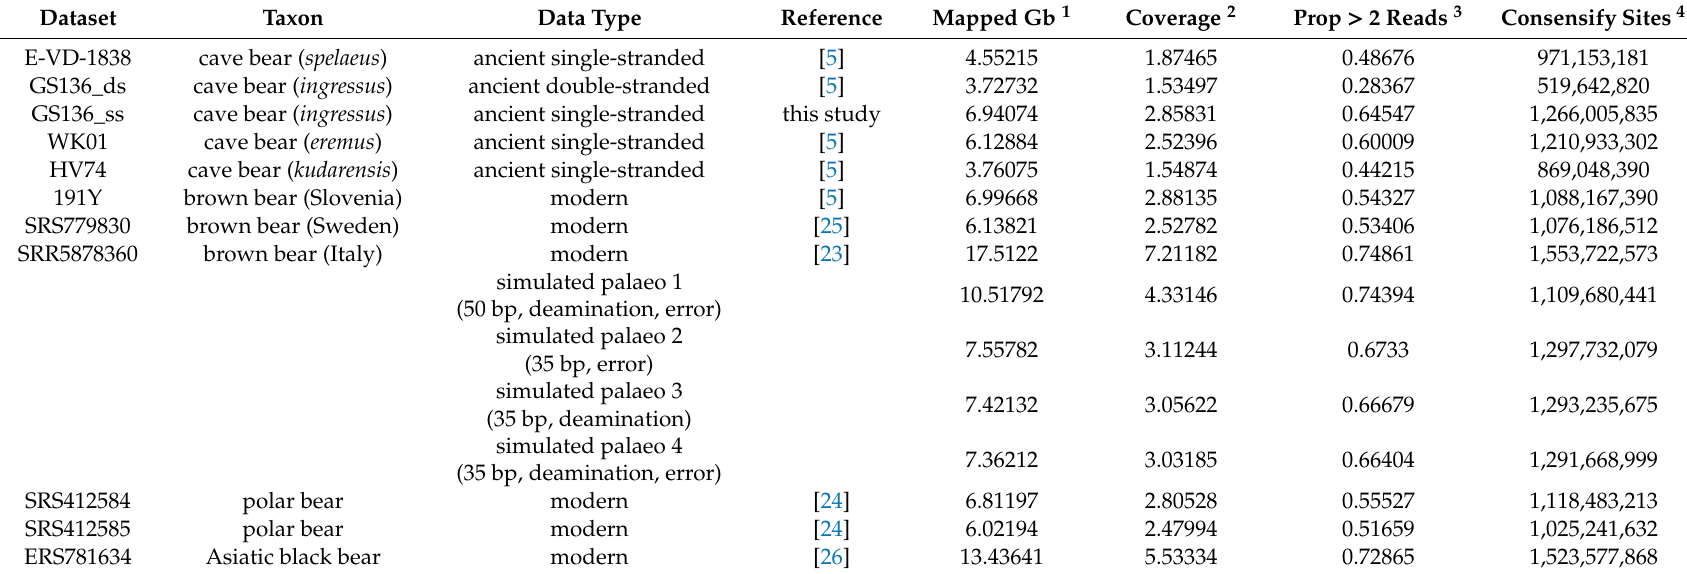
Table 2. Details of datasets included in this